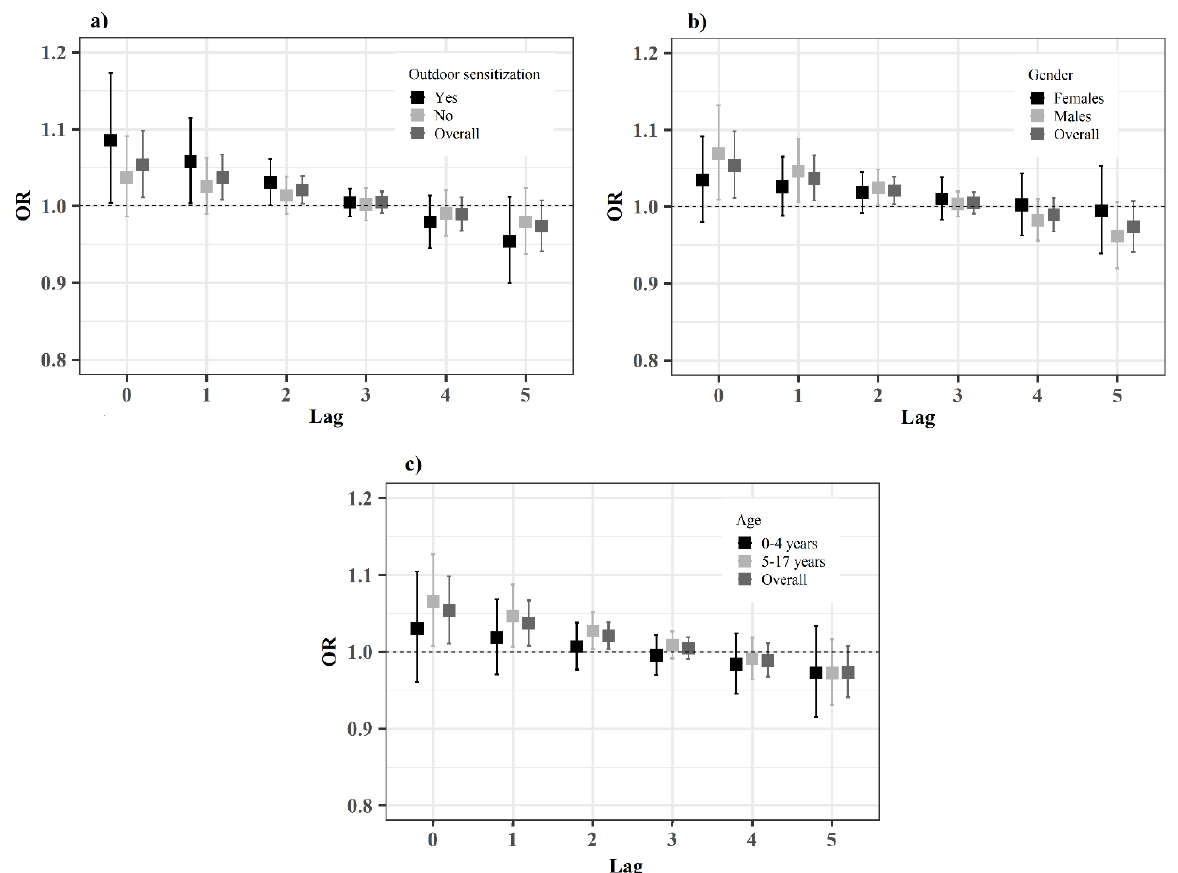
Figure 3. Acute effects of outdoor aeroallergen counts on the risk of asthma admissions: odds ratios (OR) per 10-grains/m 3 increase and 95% confidence intervals for the conditional logistic regression models with distributed lags, stratified by presence of outdoor sensitization ( a ), gender ( b ), and age group ( c ).